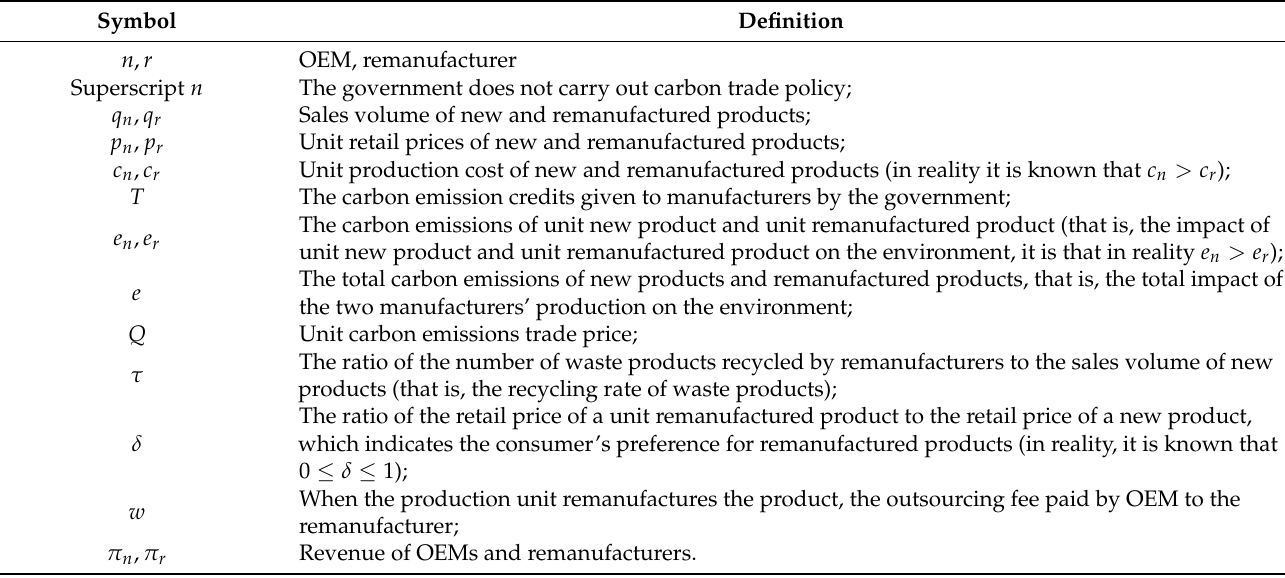
Table 1. Definition of